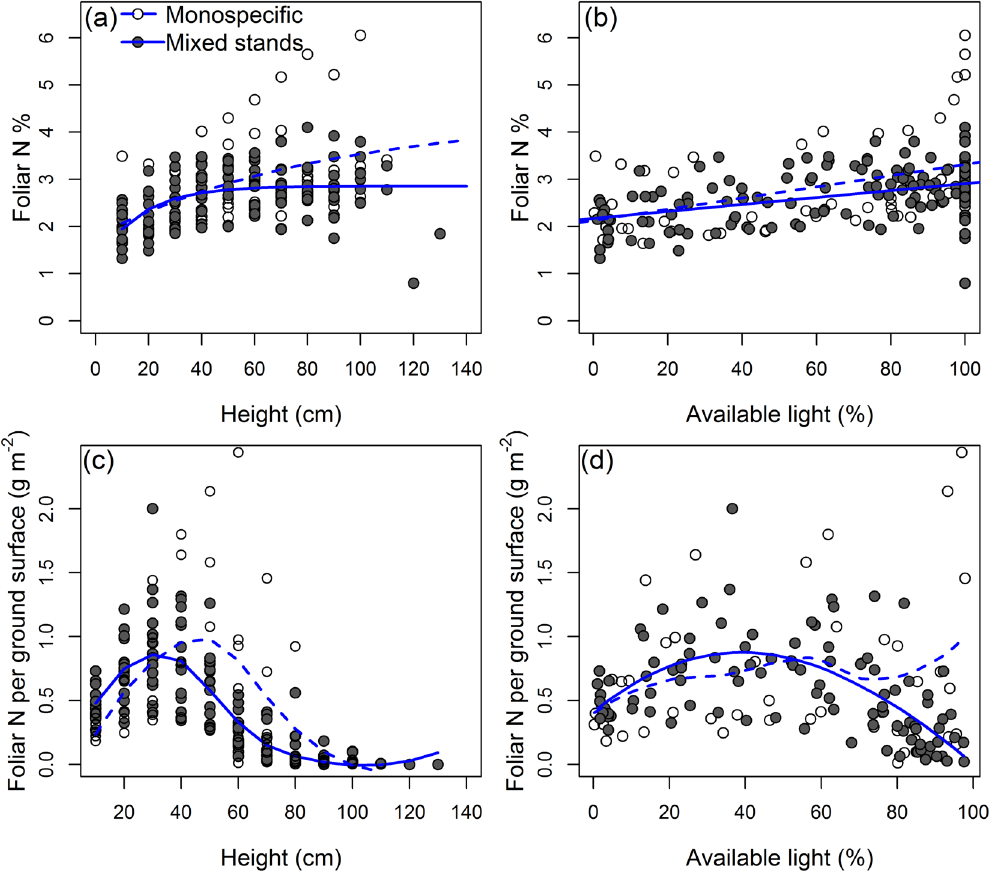
Figure 1. Relationship between the foliar nitrogen (N) concentration and ( a ) height in the canopy and ( b ) percentage of light transmission in monospecific-dominated and mixed stands. Relationship between leaf N content per ground surface area and ( c ) height in the canopy and ( d ) percentage of available